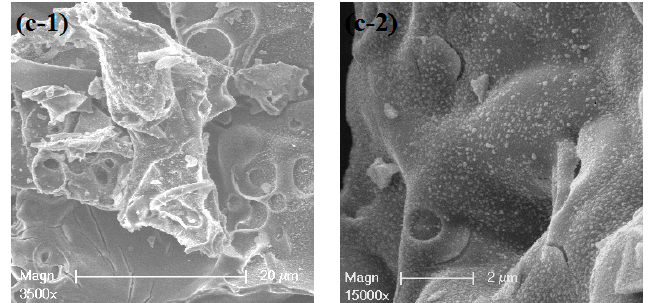
Figure 4. SEM images of ( a ) 10Ni − Al, ( b ) 10Co − Al and ( c ) 10Cu-Al calcined samples.